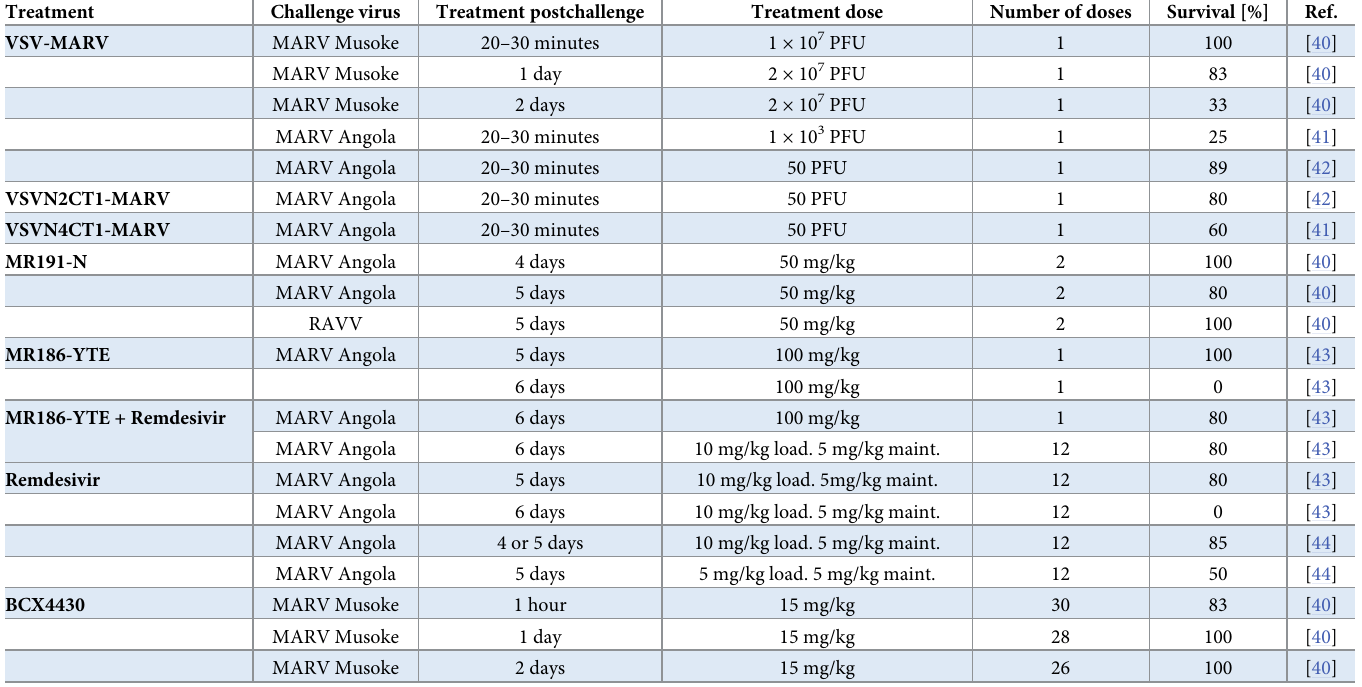
Table 2. MARV therapeutics with protective efficacy in the NHP model. Treatment Challenge virus Treatment postchallenge Treatment dose Number of doses Survival [%]